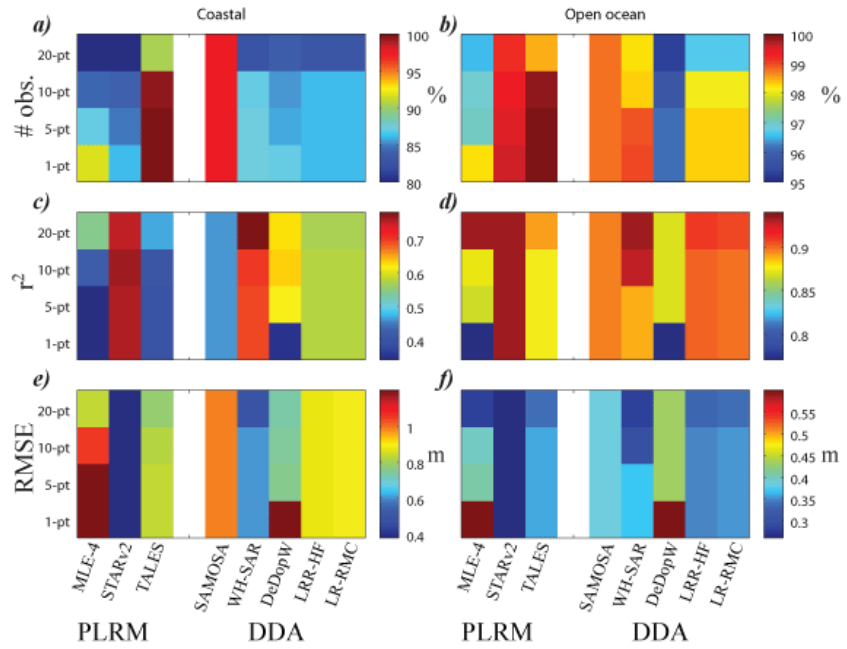
Figure 7. Effect of raising the minimum no. of observations on the number and quality of the median estimate by the Sentinel-3 altimeter. ( a , b ) show the percentage of passes exceeding the eligibility threshold; ( c , d ) show the r 2 values and ( e , f ) the root mean square error (RMSE) upon comparison with buoys. Note different colour scales are used for coastal (buoy within 15 km of coastline) and open ocean conditions to allow the variations in each panel to be clearly